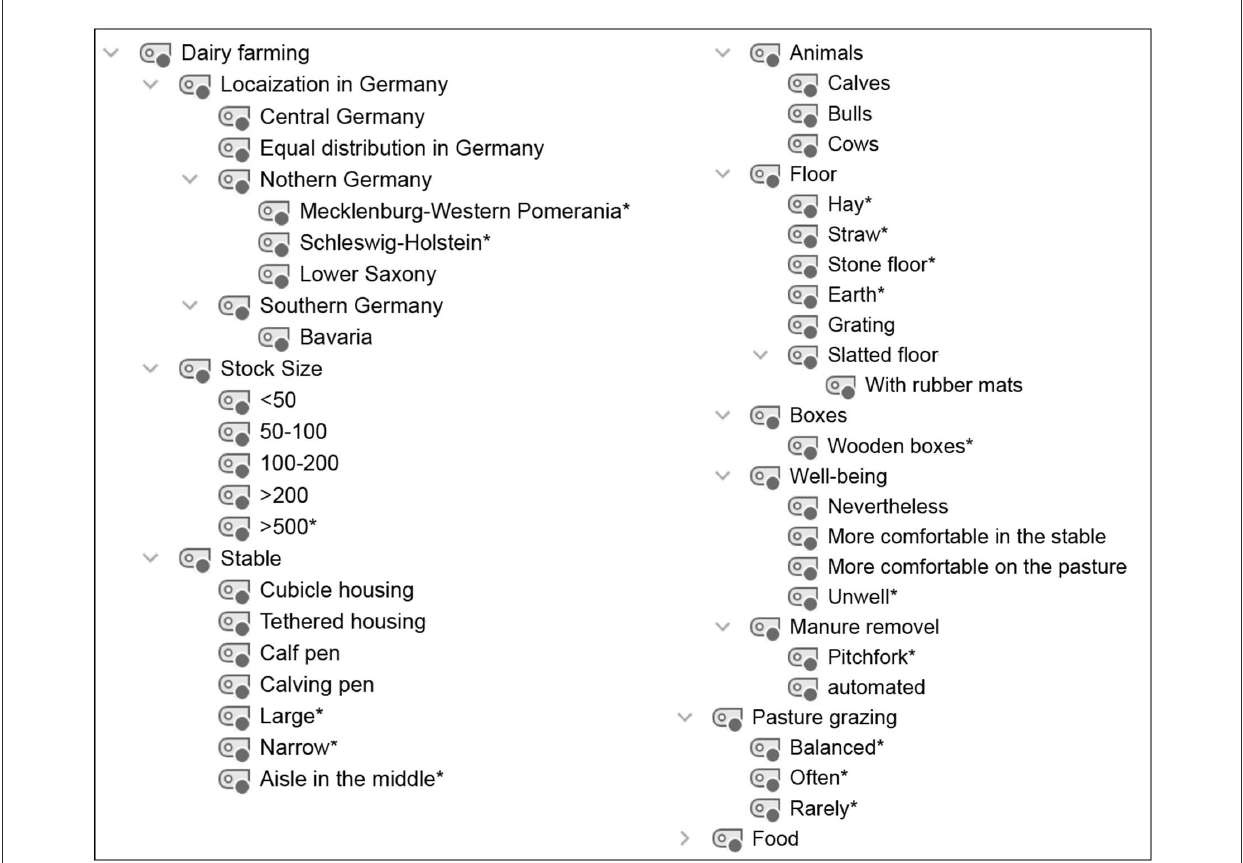
FIGURE1 Category system for analyzing student conceptions of dairy farming. * Inductively coded